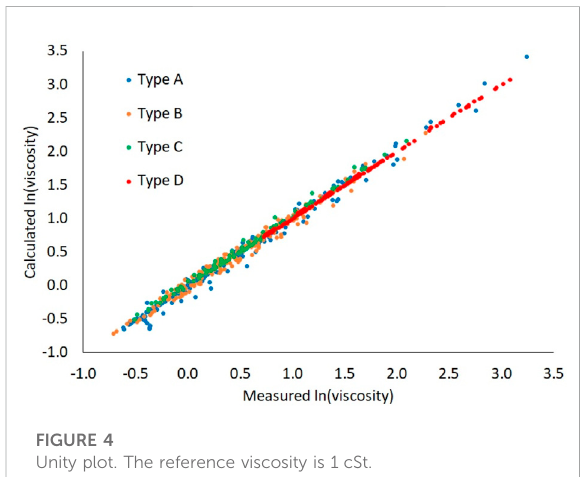
FIGURE 4 Unity plot. The reference viscosity is 1 cSt. FIGURE 5